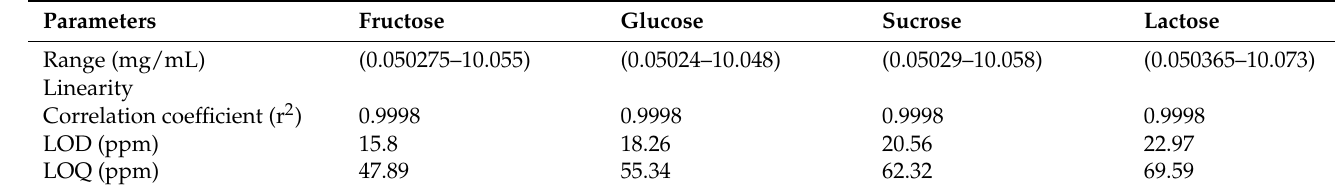
Table 3. Results of the validation parameters for sugar